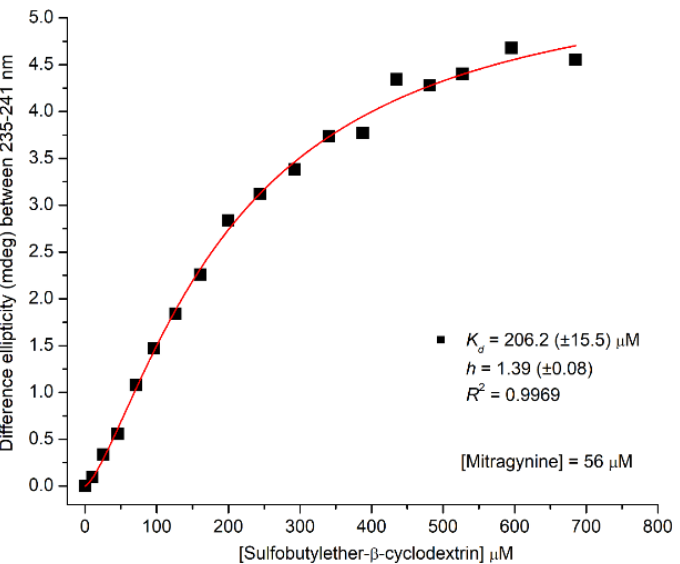
Figure 9. Difference CD values of MTR plotted as the function of SBE β CyD concentrations. Red solid line was obtained by non-linear curve fitting analysis for “one site—total and nonspecific binding” model using the Prism 6 software. Estimated value of the apparent dissociation constant and the Hill coefficient are shown.